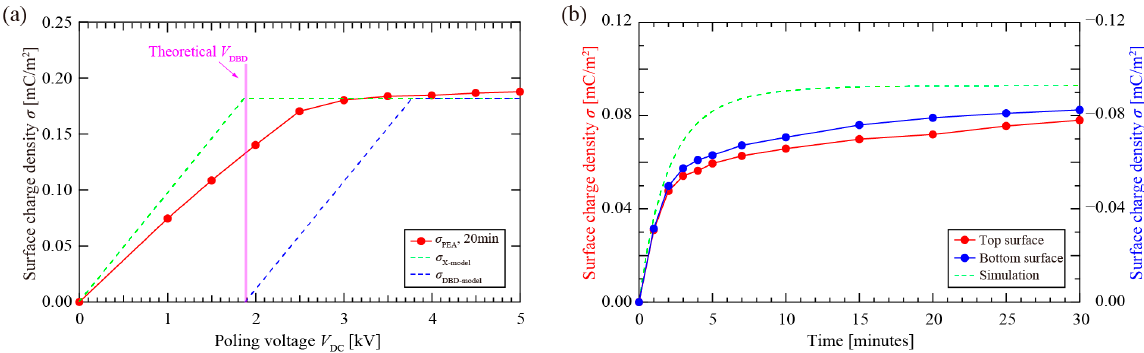
Figure 8. Surface charge densities ( σ ) of soft X-ray-charged cellular electret. ( a ) The dependence of σ on the poling voltage ( V DC ); ( b ) The dependence of σ on charging time at V DC = 1.00 kV.